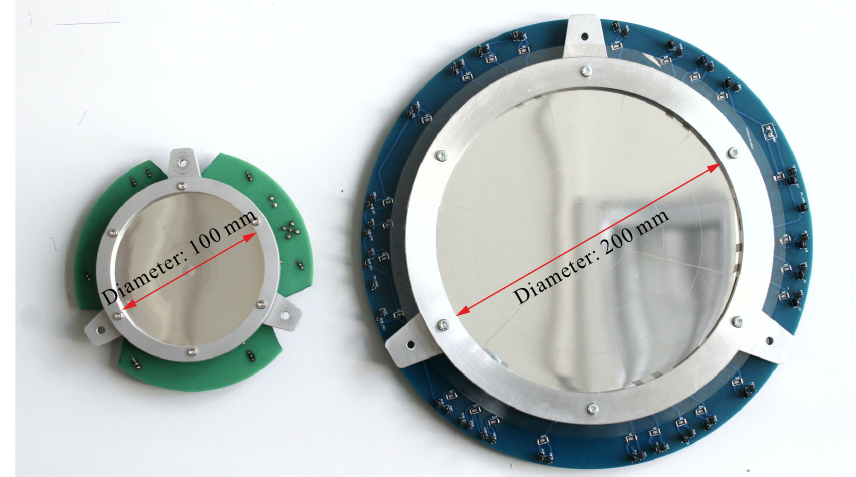
Figure 4. Demonstrators developed in the MATS project, mounted in their support. ( Left ) Spin coated reflector discussed in Reference [10]. ( Right ) Spray coated reflector of the present